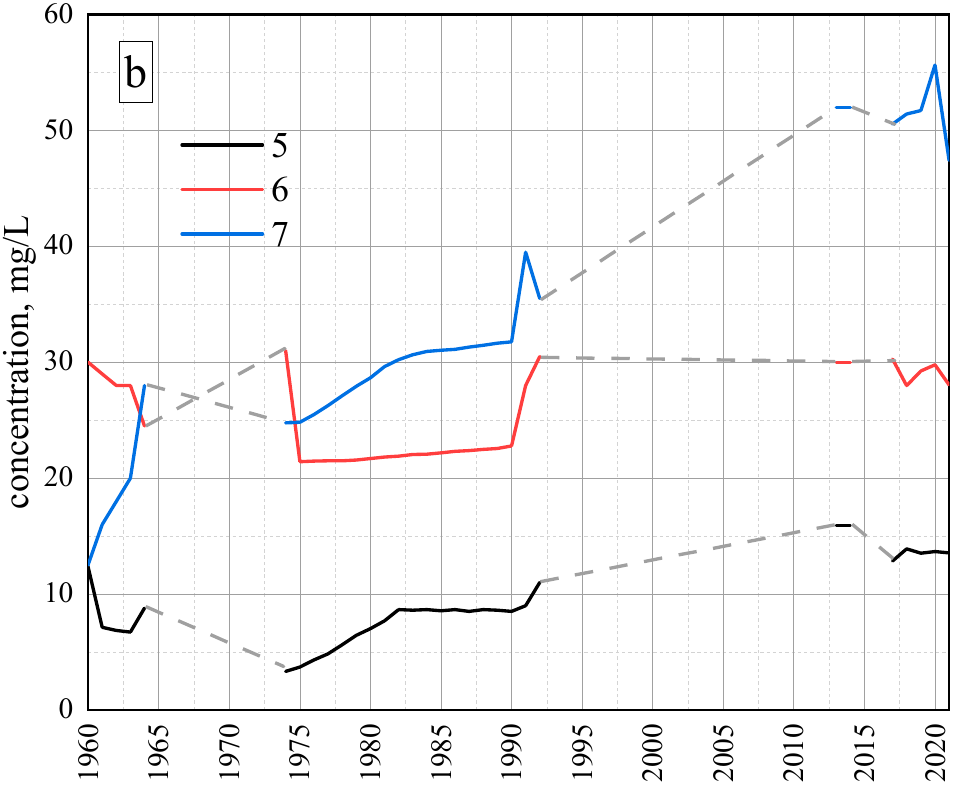
Figure 6. Changes in the concentration of anions ( a ) and cations ( b ) in the water of Lake Gusinoe (mg/L); 1958 [17], 1974-1992 [14,18], 2013 [41], 2017-2021-author’s data. 1-Cl – ; 2-SO 42– ; 3-HCO 3– ; 4-no data; 5-Mg 2+ ; 6-Ca 2+ ; 7-Na + + K + .